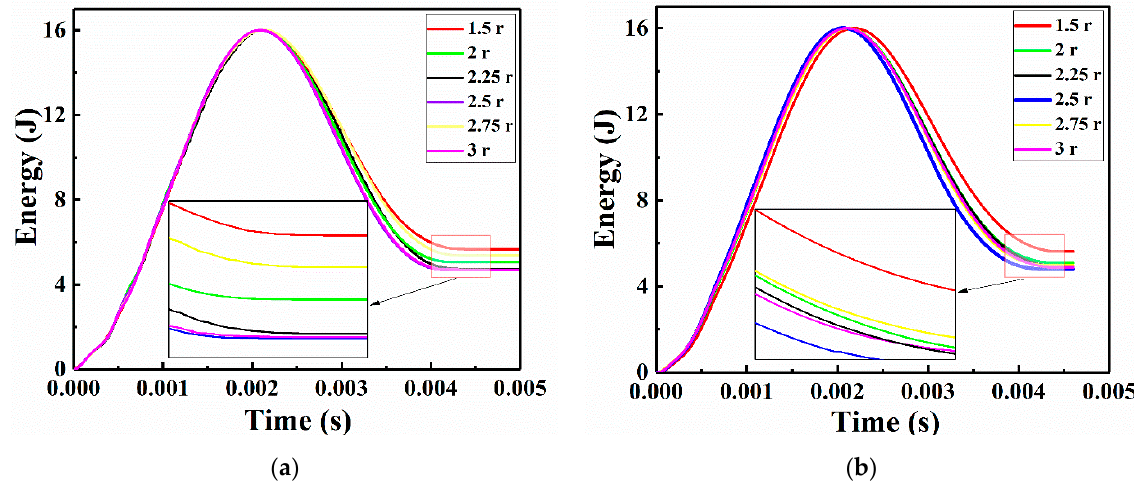
Figure 15. Impact energy curves of the CFRP laminates repaired with patches of various sizes: ( a ) numerical and ( b ) ex- perimental.